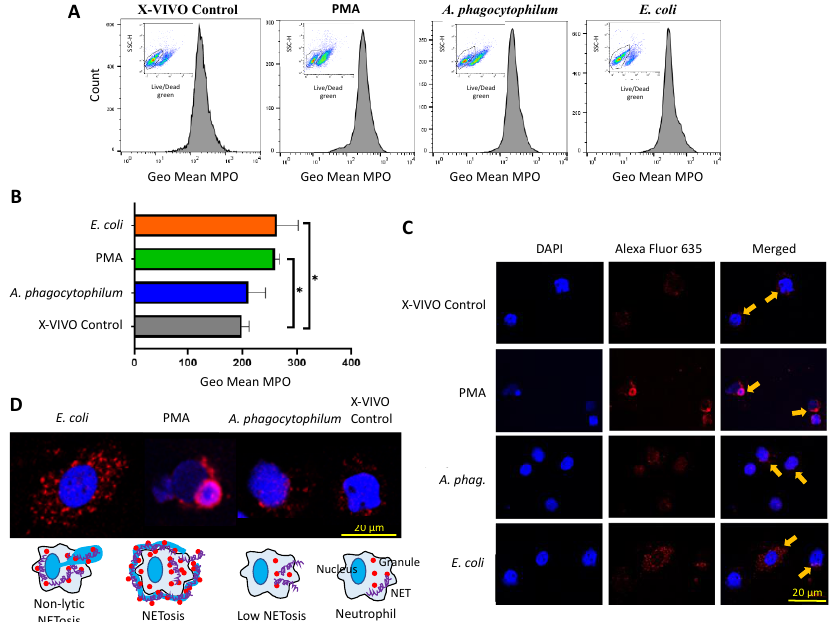
Figure 3. MPO levels in differentiated HL60 cells. ( A ) Live/dead cells were differentiated and quantified in all treatments using a fixable Green Dead cell stain Kit (Molecular Probes, Eugene, OR, USA). Then, live cells were gated to evaluate MPO expression only in these cells. Live cells were detected in the four different treatments. High resolution images are displayed in Supplementary Figure S4. ( B ) The MPO levels were quantified, and the geometric mean (Geo Mean) compared between groups by one-way ANOVA test (* p < 0.05; n = 4 biological replicates). ( C ) Representative images of immunofluorescence analysis of cells treated with X-VIVO control, PMA, A. phagocytophilum , and E. coli . Cells were stained with rabbit anti-MPO antibodies and conjugated with fluorescently labeled Alexa Fluor 635 goat anti-rabbit IgG secondary antibody (MPO in red, arrows) and labeled with DAPI (DNA in blue). ( D ) Representative images of immunofluorescence analysis and proposed associated models of induced NETosis.